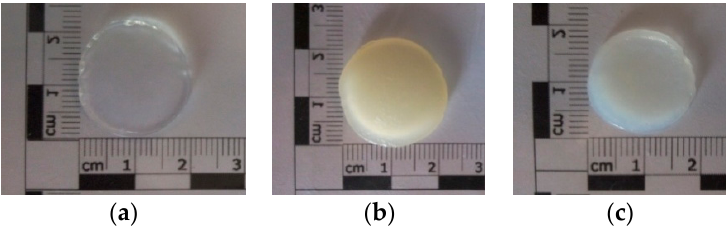
Figure 1. GelMA scaffolds after photopolymerization ( a ) 15% GelMA; ( b ) GelMA-Nanoliposomes 15%:1.5% ( w / w ); ( c ) GelMA-Emulsion 15%:1.5% ( w / w ). 15%:1.5% ( w / w ); ( c ) GelMA-Emulsion 15%:1.5% ( w / w